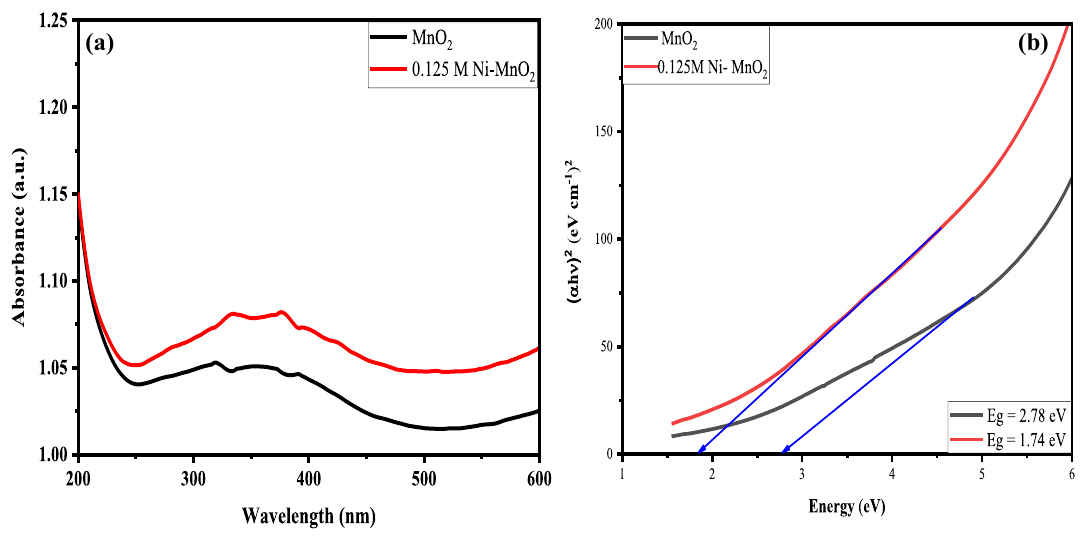
Fig. 9 UV–Vis spectra of a pure MnO